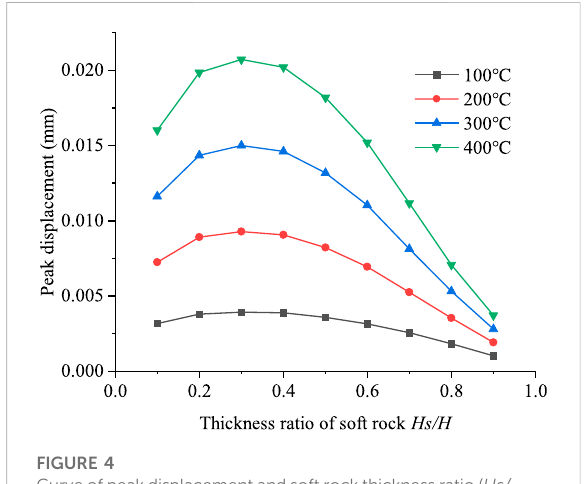
FIGURE 4 Curve ofpeakdisplacement andsoftrock thicknessratio ( Hs/ H ) under different temperature